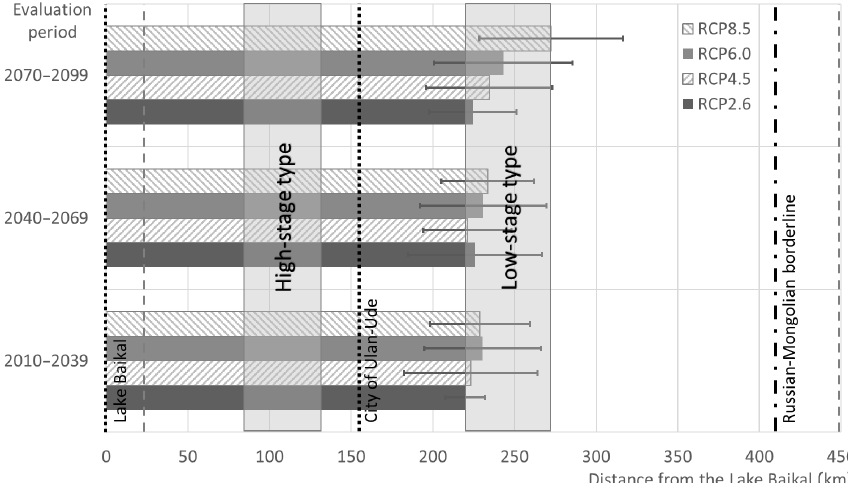
Figure 2. Projections of the Baikal omul spawning distance range in the XXI century. Horizontal bars show mean projected distance for different periods, whiskers show inter-model variance. Vertical grey dashed lines denote the historical minimum and maximum spawning ground location, the shaded areas show the two types of the migration distance from the assessment of 1984–2013 (see Sect. 3.1). Vertical black dotted line marks the location of the Ulan-Ude, black dash-dotted line shows the interstate borderline location.